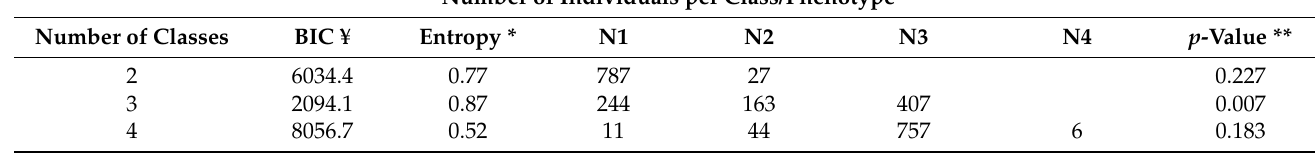
Table 2. Cluster class fitting analysis.